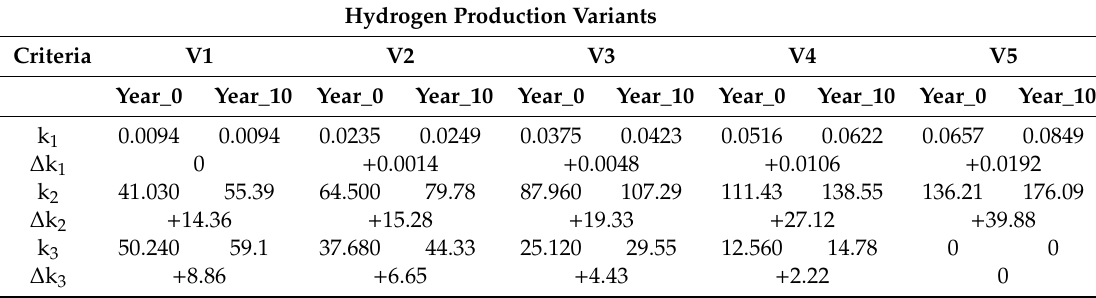
Table 3. The impact of e ffi ciency decline in electrolyzers and PV farms on the values of decision-making criteria—own